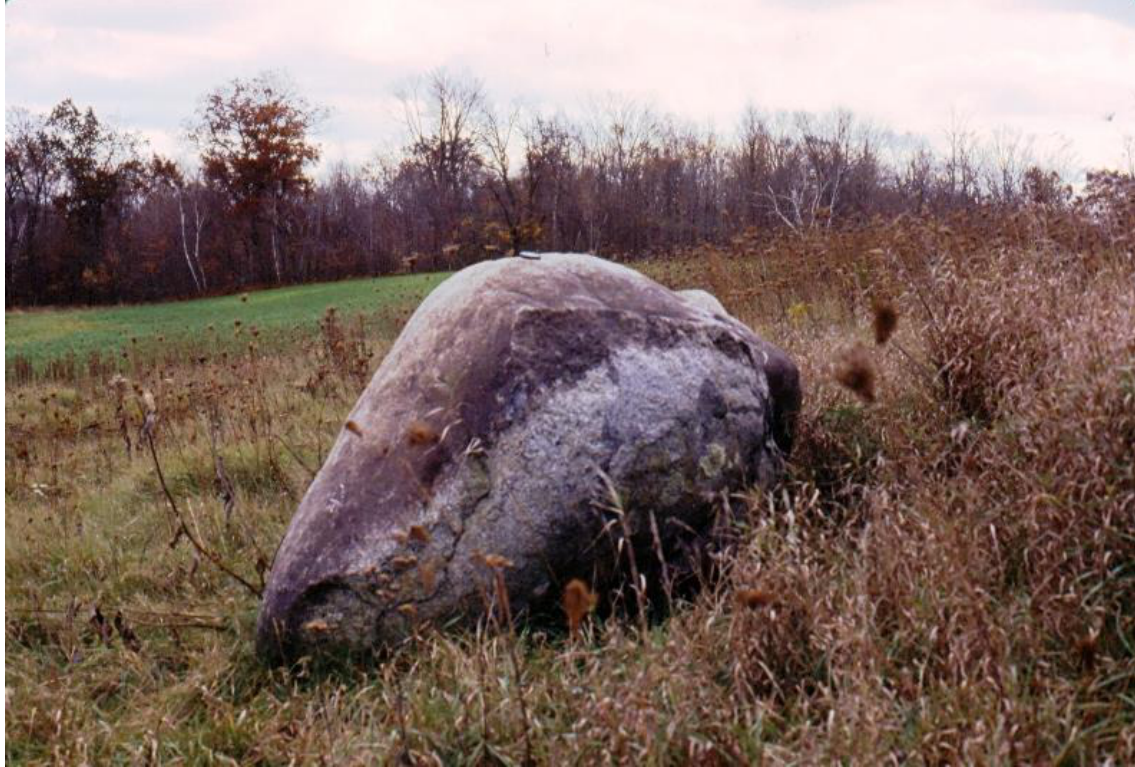
Figure 5. The large granite boulder, a glacial erratic resting on the southern end of the ‘target’ hill. It has been rolled out of place, the pit where it rested for millennia to the immediate west of the boulder. The highly weathered top is now at the bottom. View in photograph is looking